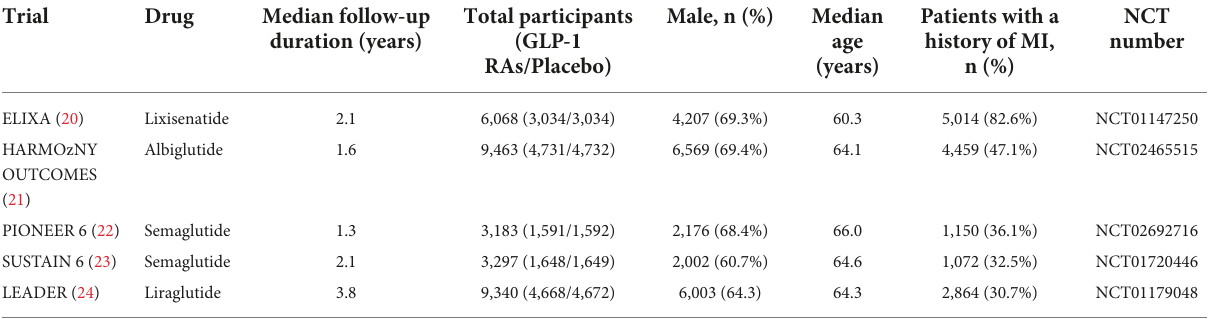
TABLE 1 Basic characteristics of the included studies